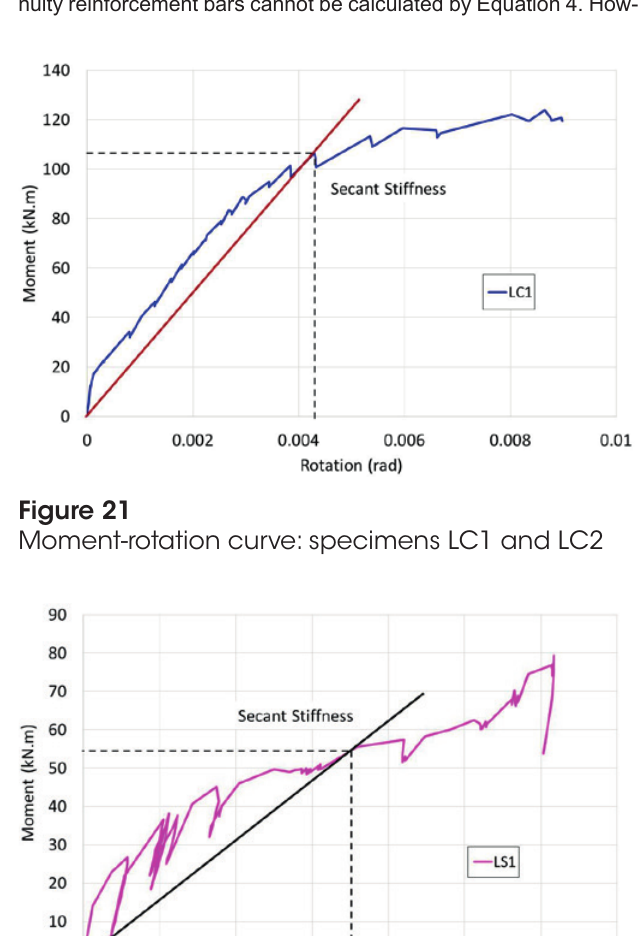
Figure 21 – Moment-rotation curve: specimens LC1 and LC2